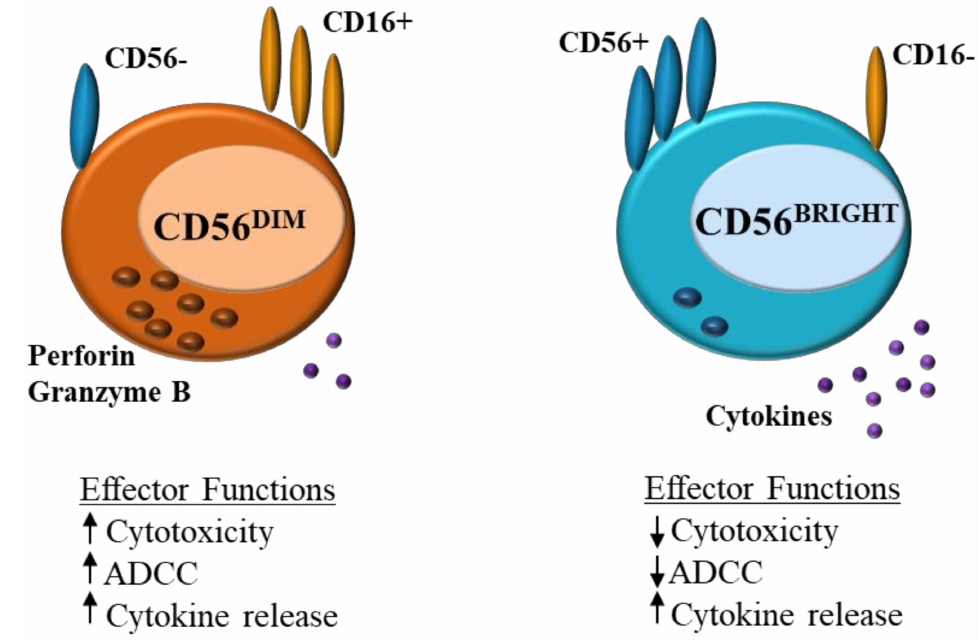
Figure 1. Natural killer (NK) cells: di ff erences in e ff ector function between CD56 DIM and CD56 BRIGHT ADCC = antibody-dependent cell